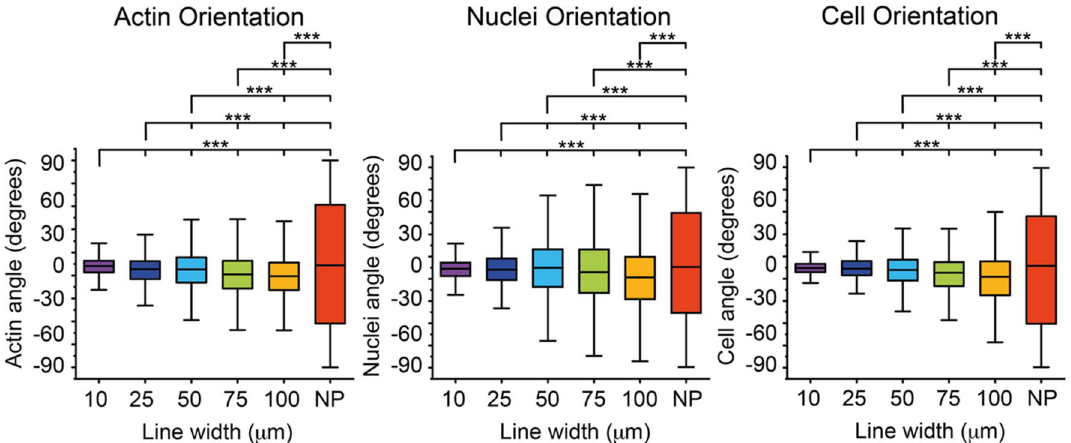
Figure 3. Brain microvascular endothelial cells align with the direction of the peptide pattern and alignment increases as the line width decreases. Box plots of actin orientation, nuclei orientation and cell orientation for the different line widths 10 µm, 25 µm, 50 µm, 75 µm, 100 µm, as well as a non-patterned (NP) control where the whole surface was covered with RGD. For the statistical analysis 400 nuclei and cells and 4000 actin fibres were used for each condition. The statistics included in figure 3 are summarized in Supplementary Tables S1, S2, S3, and *denotes p ≤ 0.05, **denotes p ≤ 0.01, and ***denotes p ≤